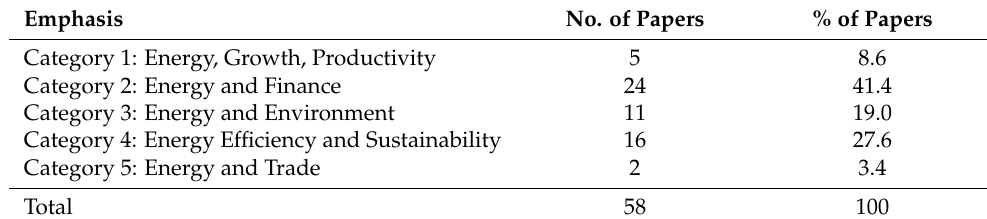
Table 3. Number of papers by area of emphasis—Energies.